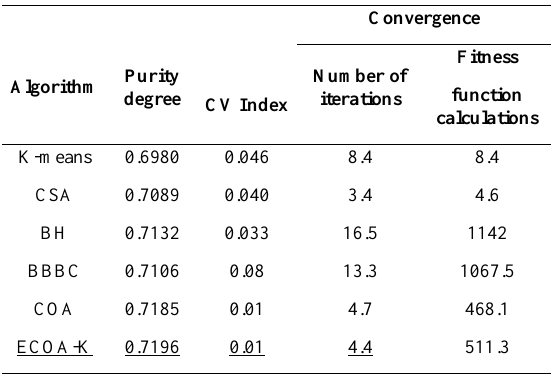
Table 8. Experimental results on wine dataset.